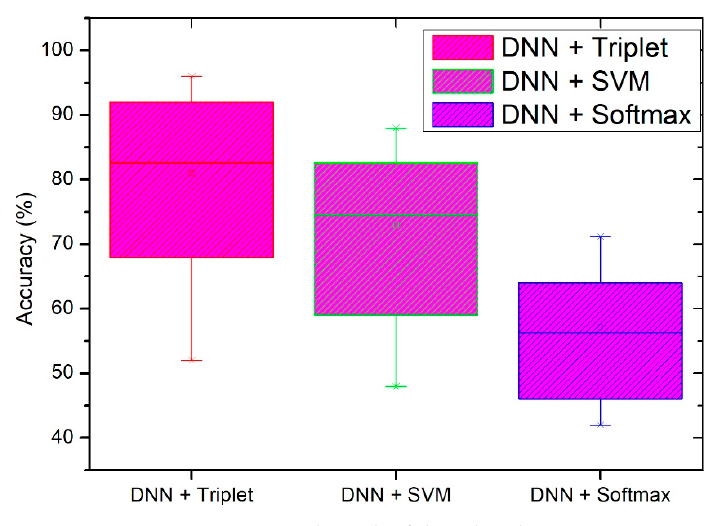
Figure 7. Statistical graph of data distribution.